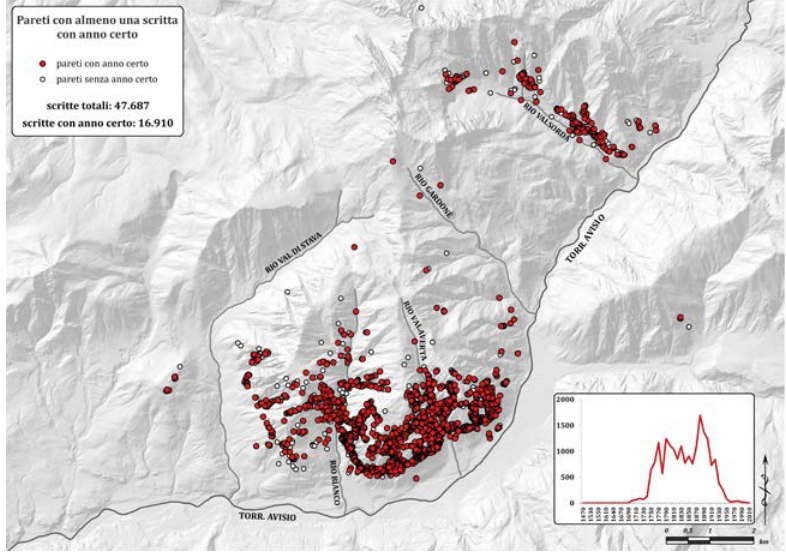
Figure 4 – Mount Cornón: spatial distribution of the walls with writings and chronology. Graphic processing by Roberta Covi. Courtesy of Museo degli Usi e Costumi della Gente